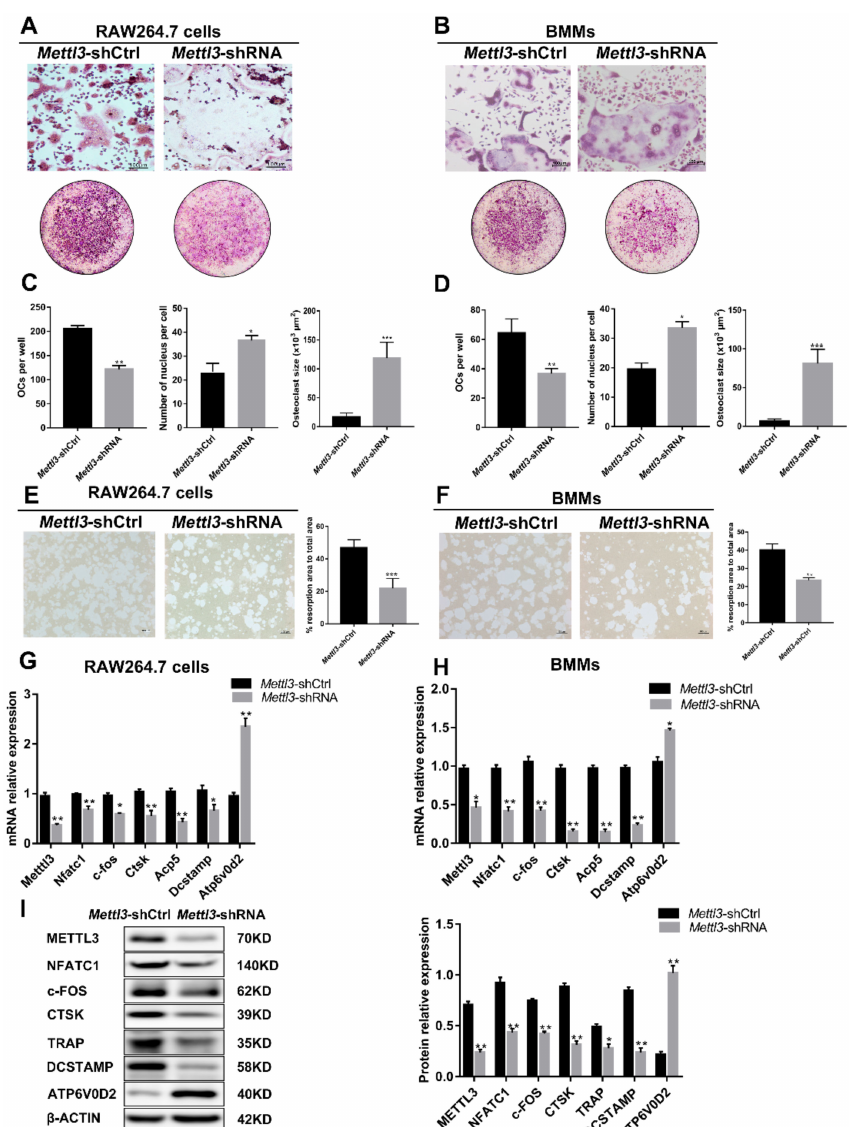
Figure 3. E ff ect of Mettl3 knockdown on osteoclast formation and function. RAW264.7 cells ( A , C , E , G , I ) and BMMs ( B , D , F , H ) in the Mettl3 -shCtrl or Mettl3 -shRNA groups were induced to di ff erentiate into osteoclasts. ( A , B )TheimagesofTRAPstainingshowedmatureosteoclastsdi ff erentiatedfromRAW264.7 cells ( A ) and BMMs ( B ). The upper images are at high microscope power (original magnification 100 × ). The under images are at low microscope power (original magnification 5 × ). ( C , D ) Number of TRAP-positive multinuclear cells per well and number of nuclei in the cultured TRAP-positive osteoclasts. The average size of each osteoclast ( × 10 3 µ m 2 ) was determined by image analysis using the ImageJ software. ( E , F ) Resorption activity of osteoclasts in the Mettl3 -shCtrl and Mettl3 -shRNA groups was assessed by pit formation assay. The “black” scale bars represent 100 µ m. The osteoclast resorption area as a percentage of total area was calculated using Image-Pro. ( G , H ) The mRNA levels of Nfatc1 , c-fos , Ctsk , Acp5 , Dcstamp and Atp6v0d2 were measured by qRT-PCR. ( I ) The protein levels of NFATC1, c-FOS, CTSK, TRAP, DCSTAMP and ATP6V0D2 were assessed by Western blotting. The band densities were analyzed using ImageJ. β -Actin was used as a normalization control. All of the data are presented as the mean ± SD ( n = 3). Significant di ff erences relative to the Mettl3 -shCtrl group. * P < 0.05; ** P < 0.01; *** P <